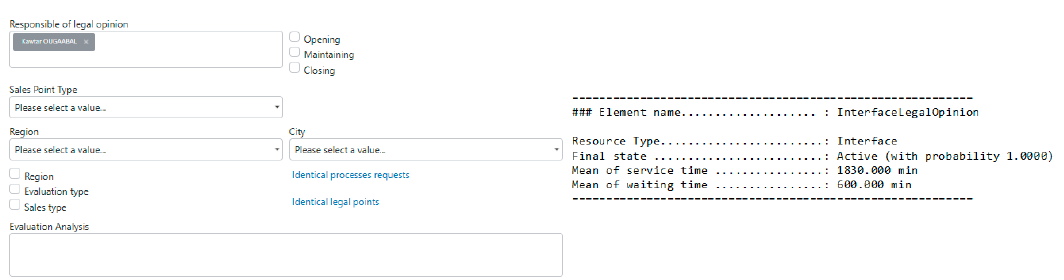
Figure 22. User interface results after improvement.